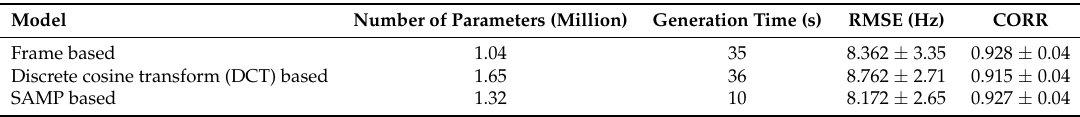
Table 7. Objective results of proposed model compared with baseline